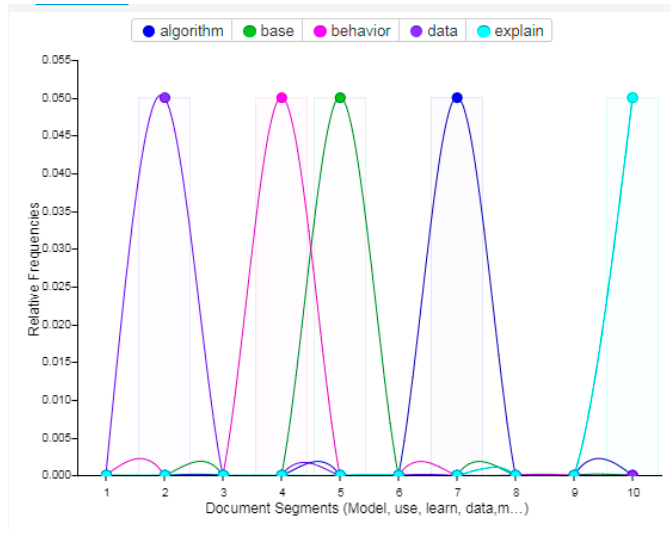
Figure 4. Word cloud 2 analysis.